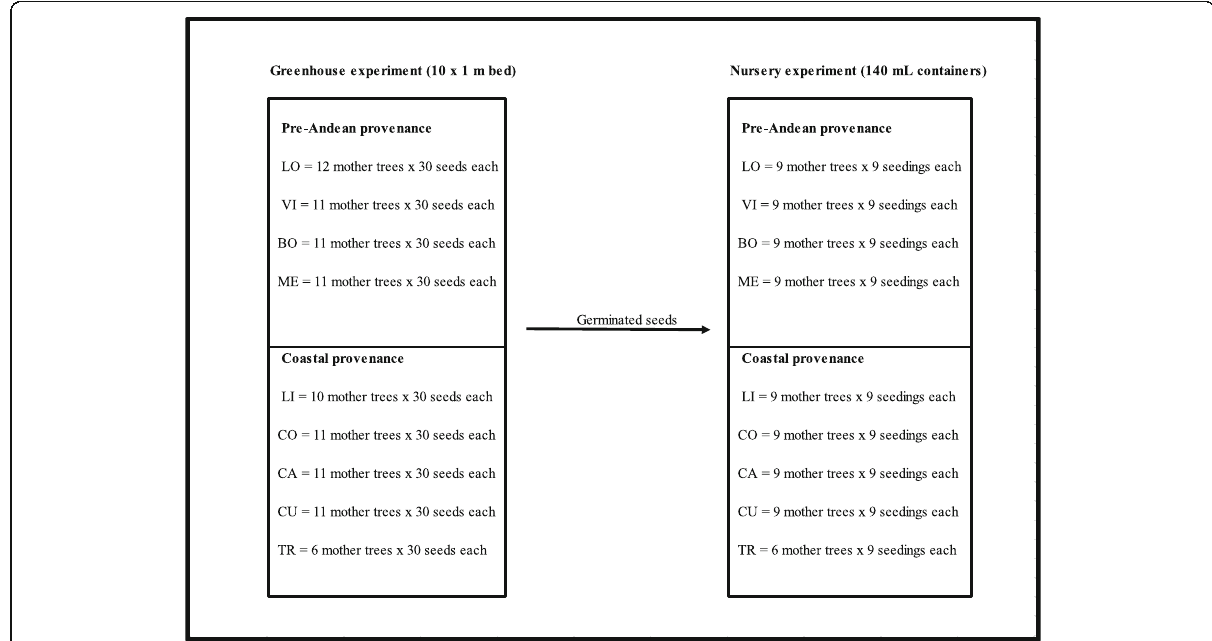
Fig. 2 Schematic diagram for germination and seedling growth